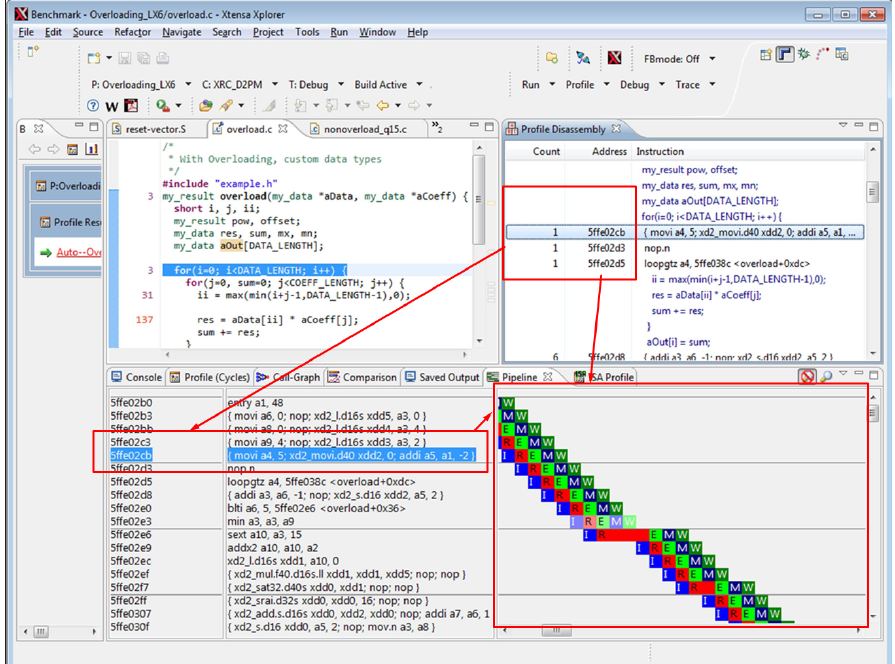
Figure 3. The pipeline viewer facilitates comprehension of instruction delays and latency prob- lems